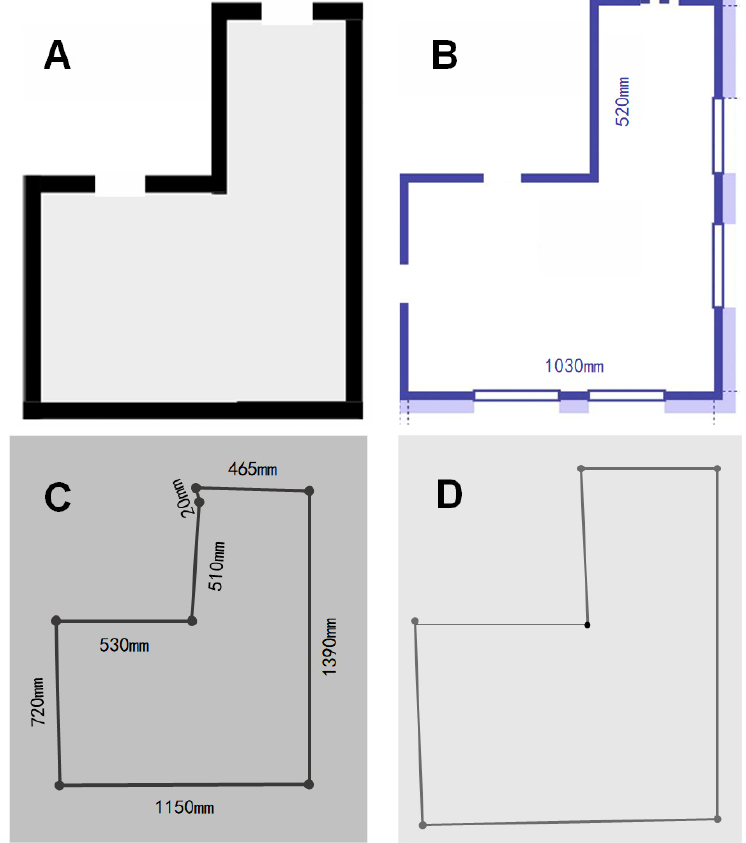
Figure 15. Side-by-side comparison results of the same building: ( A ) RoomScan; ( B ) ARSnap; ( C ) ARPlan3D; ( D ) Magicplan.